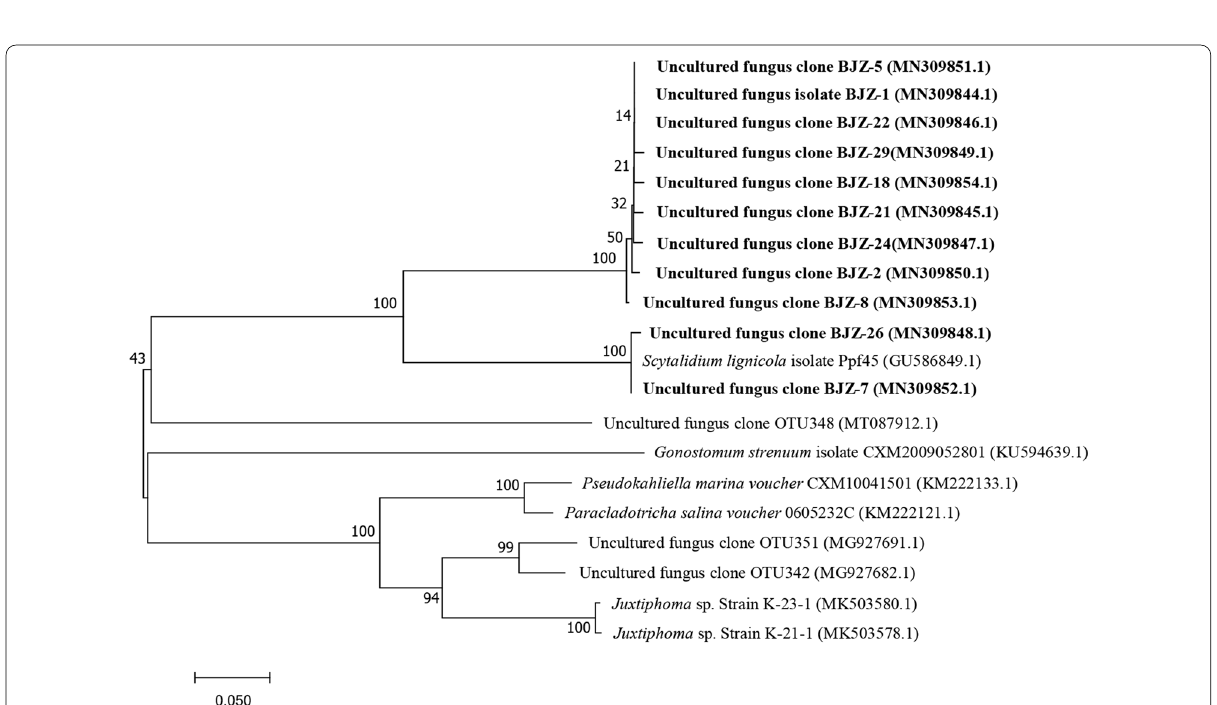
Fig. 3 Phylogenetic tree of cultivable microorganisms